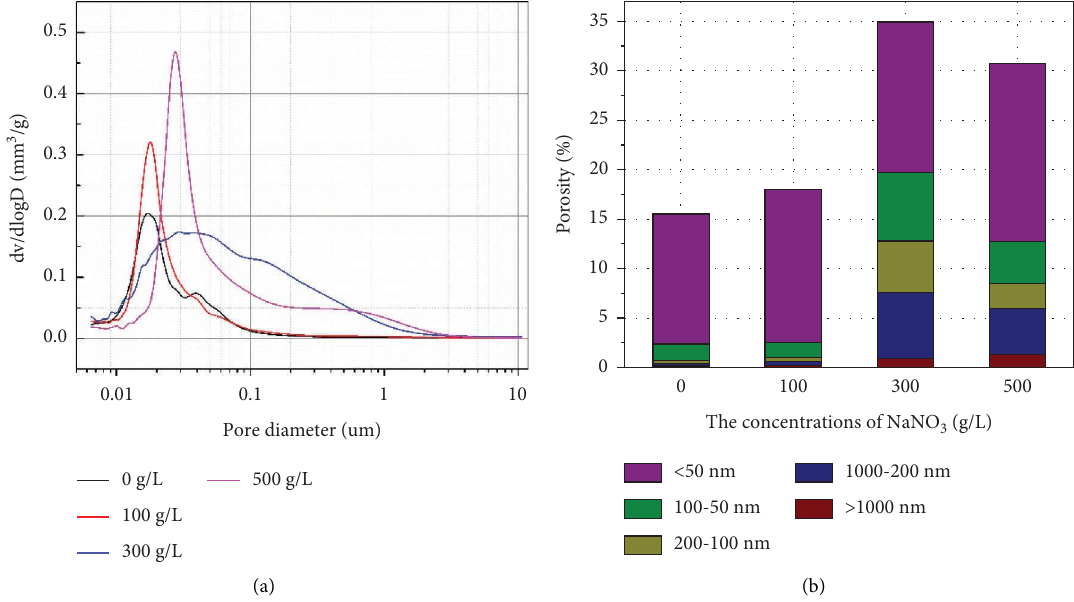
Figure 15: Te pore structure of the SFCM with diferent concentrations of sodium nitrate after curing at 90 ° C for 28d. (a) Distribution curve; (b) porosity ratio. Table 4: Te pore structure parameters of the SFCM with diferent concentrations of sodium nitrate after curing at 90 ° C for 28 d. NaNO 3 concentration